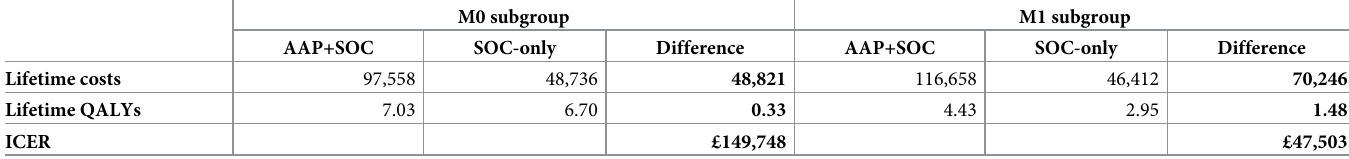
Table 1. Total lifetime per-patient costs and QALYs split by arm and subgroup, calculated using the deterministic base-case simulation analysis, and corresponding ICERs by subgroup.